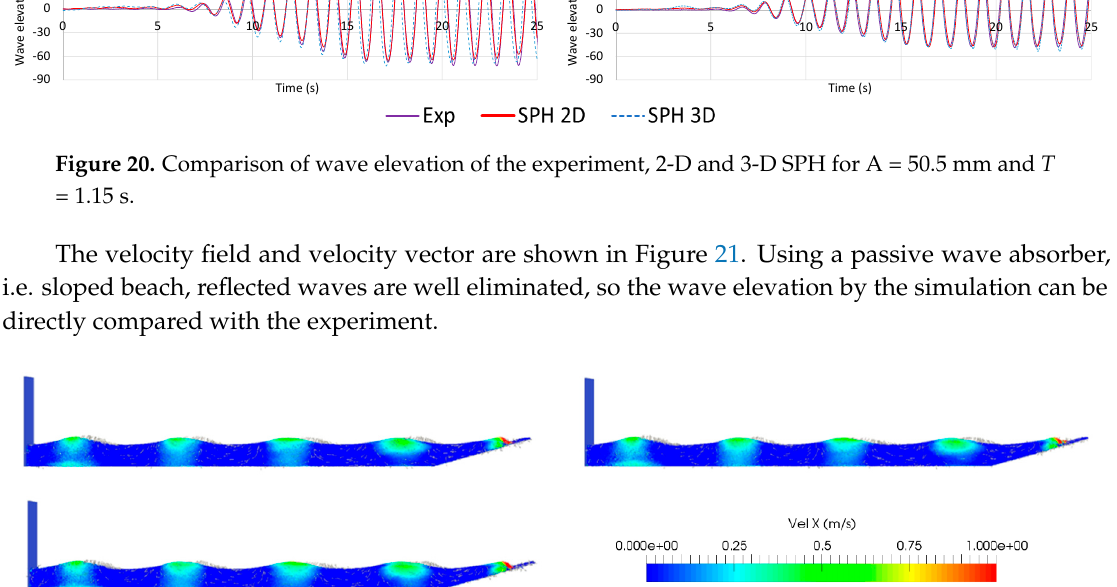
Figure 21. Velocity field and velocity vector of 3-D SPH at t = 17.25 s, 19.55 s & 21.85 s.